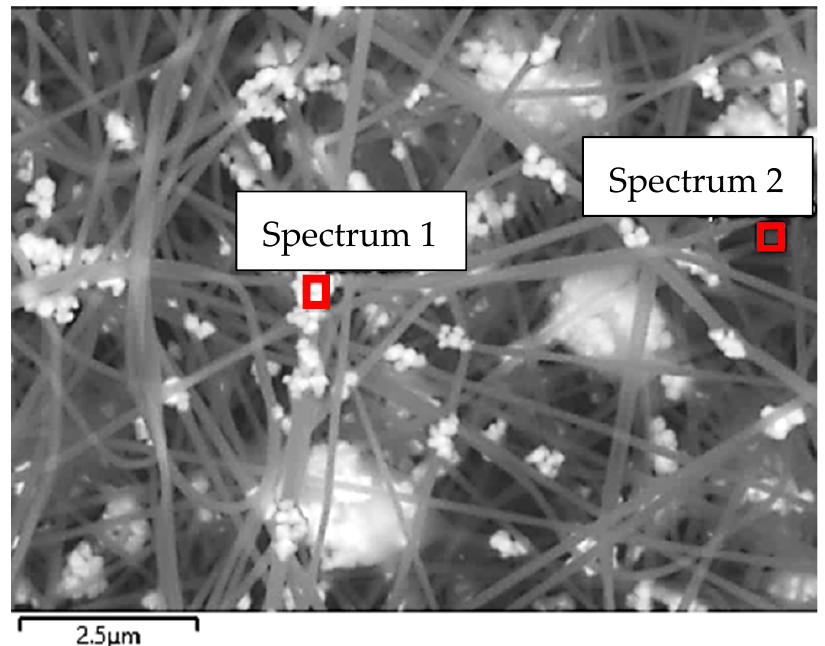
Figure 8. SEM image of PAN/magnetite nanofiber mat ( a ) spot on a bead (Spectrum 1); and ( b ) spot on a nanofiber (Spectrum 2). The scale bar indicate 2.5 μ m.